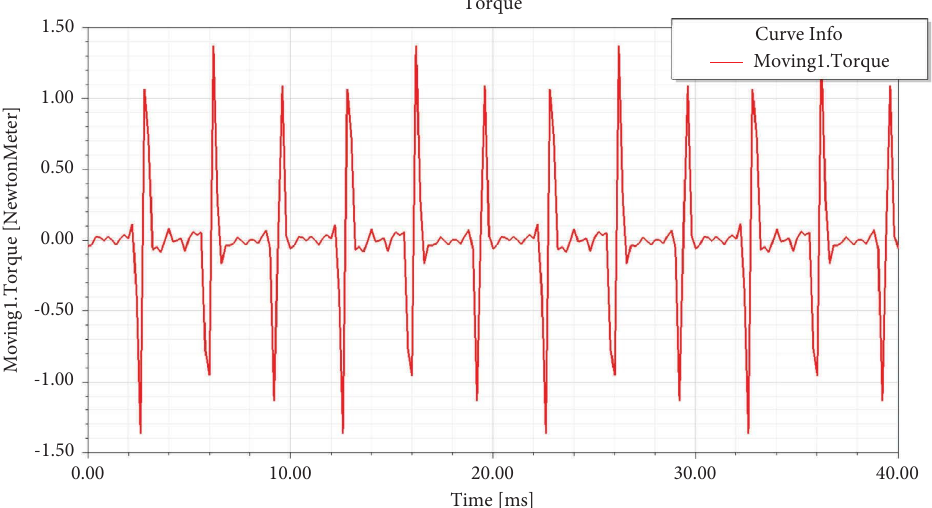
Figure 9: Reluctance torque curve of 4-pole 12-slot